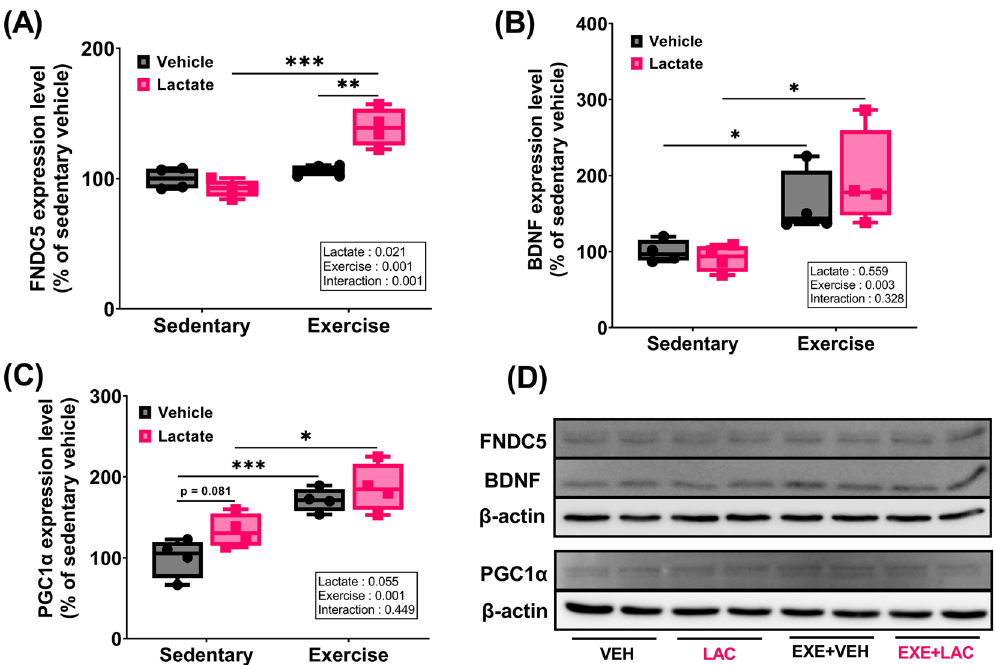
Figure 6. Exercise with lactate administration effectively enhanced the hippocampal molecules relevant to exercise-induced adult hippocampal neurogenesis. Level of protein expression of hippocampal ( A ) FNDC5, ( B ) BDNF, and ( C ) PGC1α in mice. ( D ) The represent image of western blot. Two-way ANOVA was performed, and independent Student’s t -test was used for post hoc test ( n = 4 per group). The original blots are presented in Supplementary Figs. 1 and 2. VEH sedentary without lactate, LAC sedentary with lactate, EXE + VEH exercise without lactate, EXE + LAC exercise with lactate, FNDC5 fibronectin type III domain-containing protein 5, BDNF brain derived neurotrophic factor, PGC1α peroxisome proliferator-activated receptor gamma coactivator 1-alpha; * p < 0.05, ** p < 0.01, and *** p ≤ 0.005. Data are presented as box